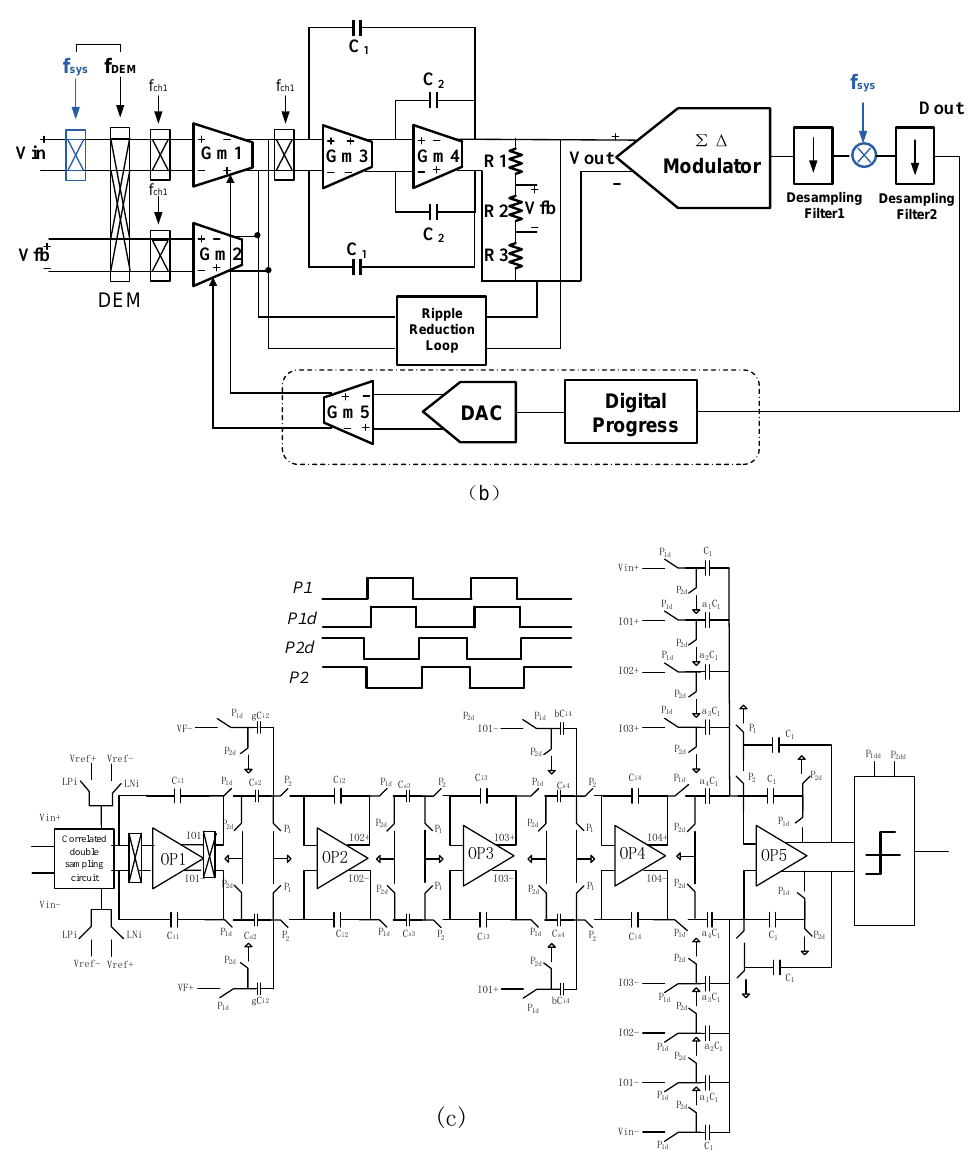
Figure 3. ( a ) Tunneling magnetic resistance-type sensitive structure, the physical printed circuit board (PCB) diagram is underneath the blue arrow ( b ) Three-axis digital tunneling magnetic resistance-type (TMR) sensor interface circuit System block diagram, the closed-loop feedback control of digital progress is shown in the dotted box ( c ) The fully differential 4th-order Sigma-Delta modulator.